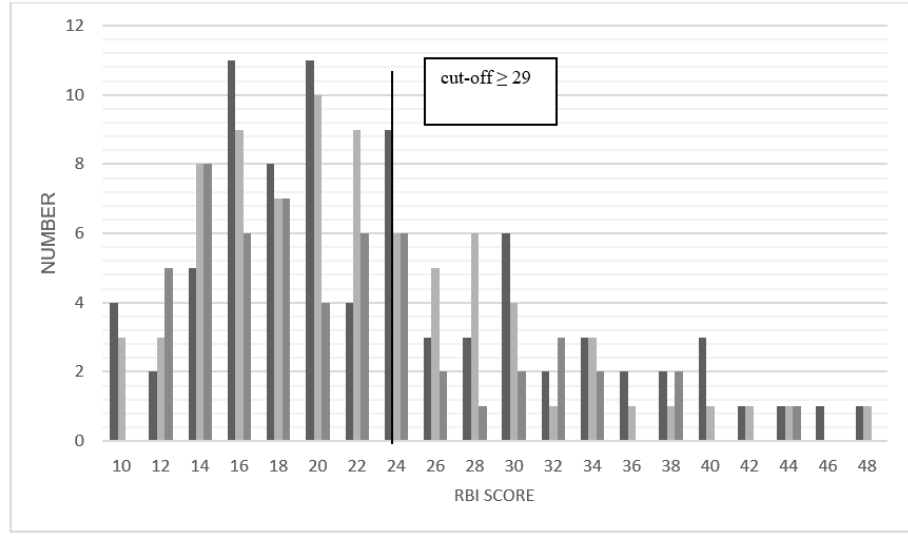
Figure 2. Overview over the distribution of the RBI scores (FKB-20). notes: black bars represent the RBI score at TP1 ( n = 82), light grey bars at TP2 ( n = 80) and dark grey bars at TP3 ( n = 55).